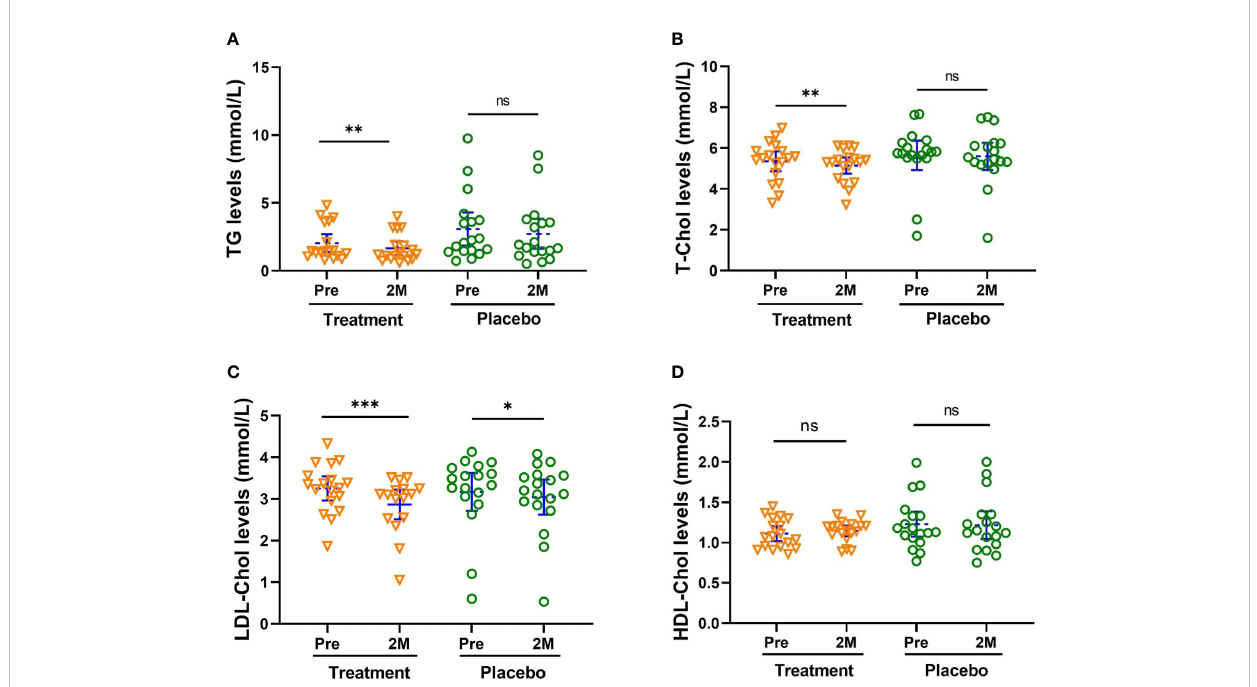
FIGURE 3 W-LHIT signi fi cantly reduced total cholesterol (TC), blood triglycerides (TG) and low-density lipoprotein cholesterol (LDL-C). (A) TC; (B) TG; (C) LDL-C; (D) HDL-C. Bars were shown as mean of each group with 95% CI. All intra-group analyses were performed using one-way ANOVA followed by Bonferroni post hoc , and inter-group was performed by using t test followed by Mann-Whitney by Prism 9 software (*, ** and *** represent p < 0.05, p < 0.01, p < 0.001, ns represents no signi fi cant difference). TC, Total cholesterol; TG, triglycerides; LDL-C, low-density lipoprotein; and HDL-C, high- density lipoprotein cholesterol.